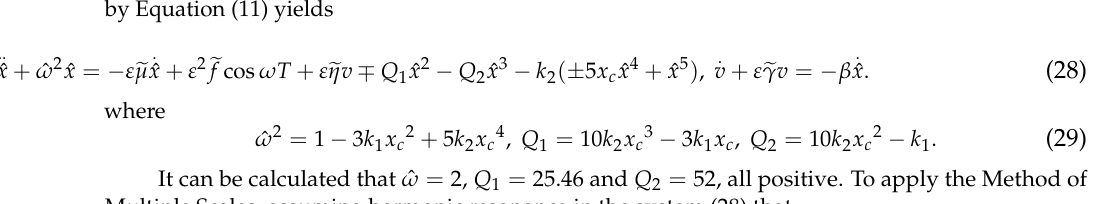
where It can be calculated that ˆ ω = 2, Q 1 = 25.46 and Q 2 = 52, all positive. To apply the Method of Multiple Scales, assuming harmonic resonance in the system (28)